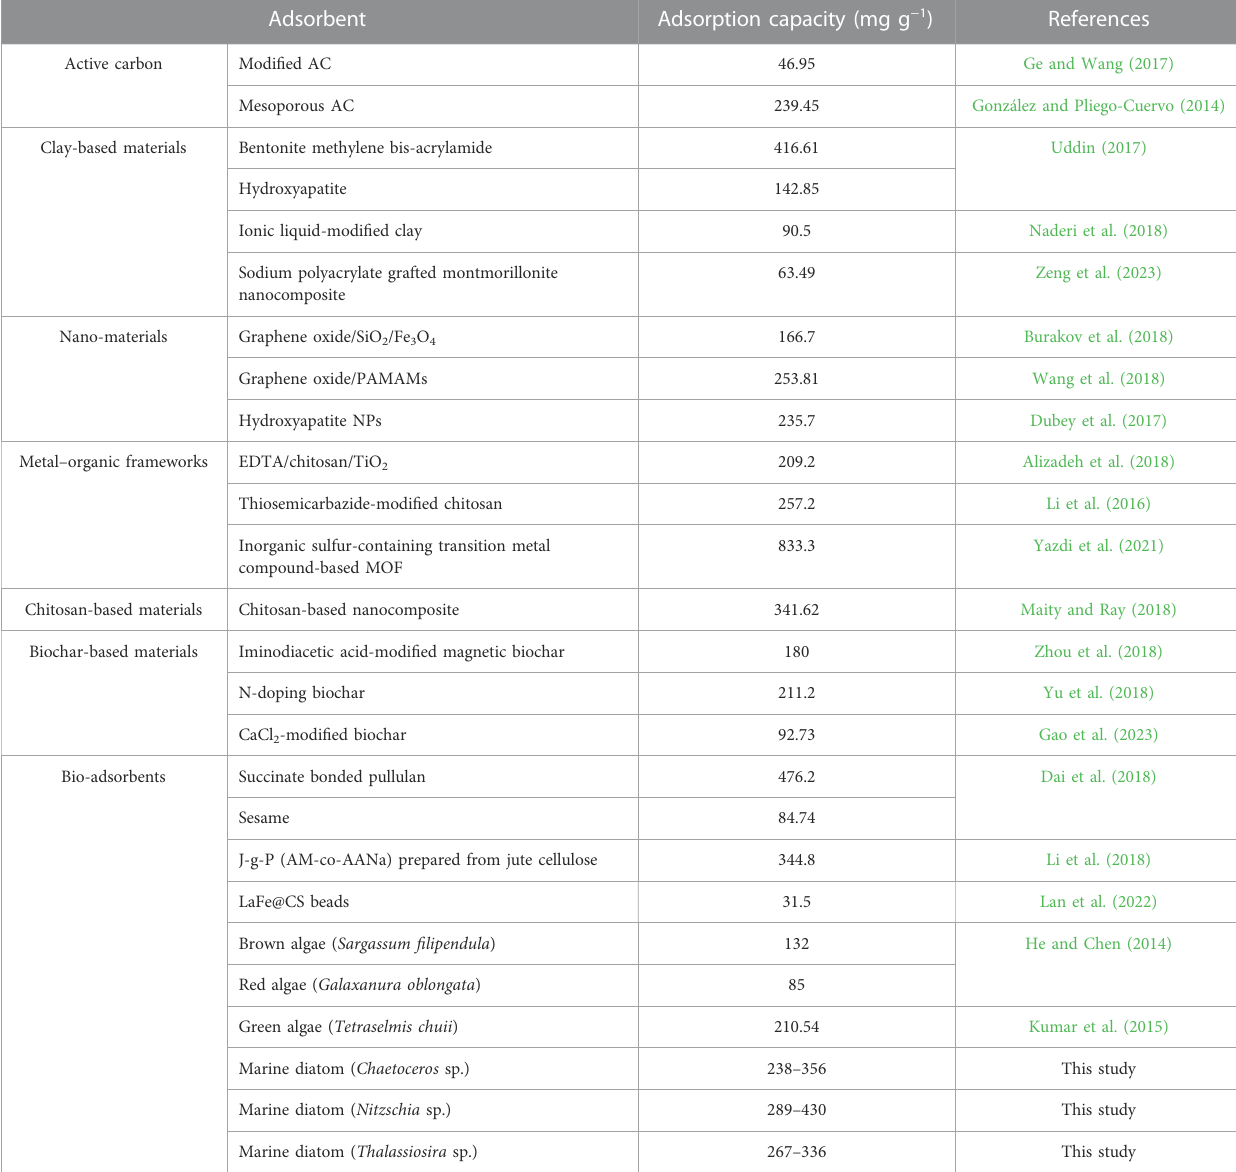
TABLE 3 Comparisons of Cd adsorption capacities between non-living marine diatom biomass and highly ef fi cient adsorbents reported